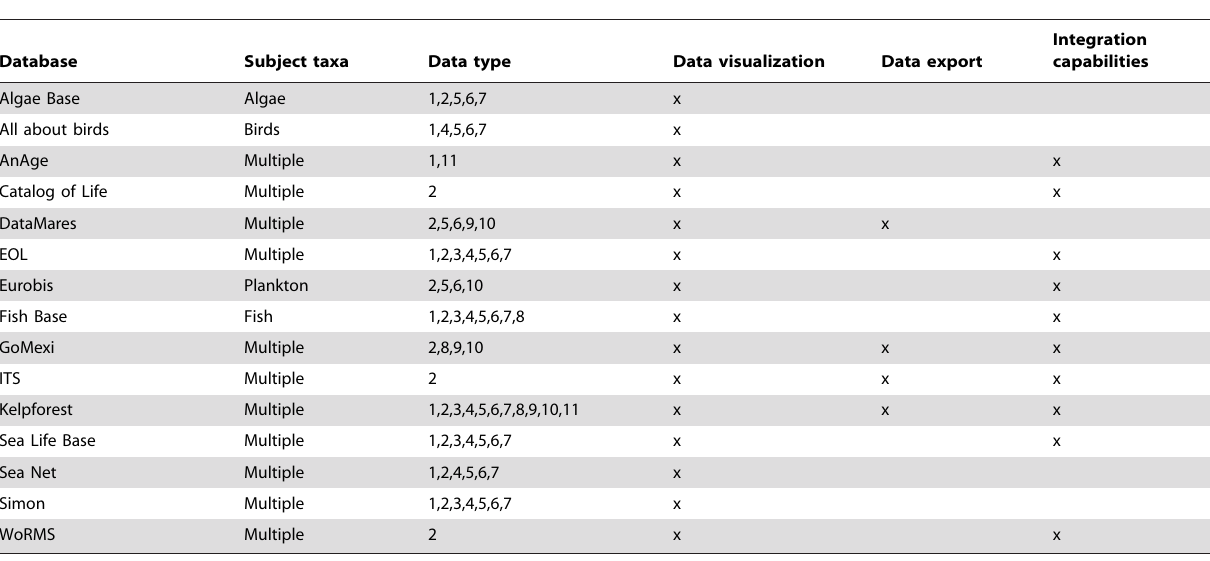
Table 2. List of some of the most relevant marine ecological databases and their attributes to inform ecosystem